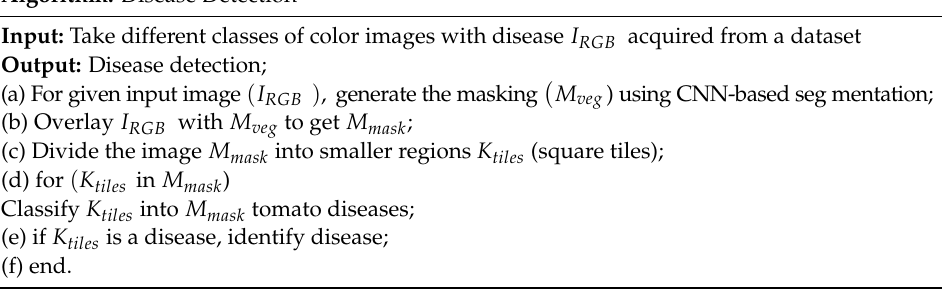
9 of 16 Proposed Algorithm: Steps involved for Disease Detection Step 1 : Input color of the image I RGB of the leaf procure from the PlantVillage dataset. Step 2 : Given I RGB , generate the mask M veq using CNN-based segmentation. Step 3 : Encrust I RGB with M veq to get M mask .